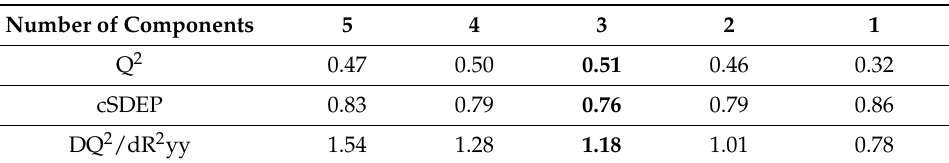
Table 4. Progressive scrambling test results obtained for the comparative molecular similarity indices analysis (CoMSIA) model.